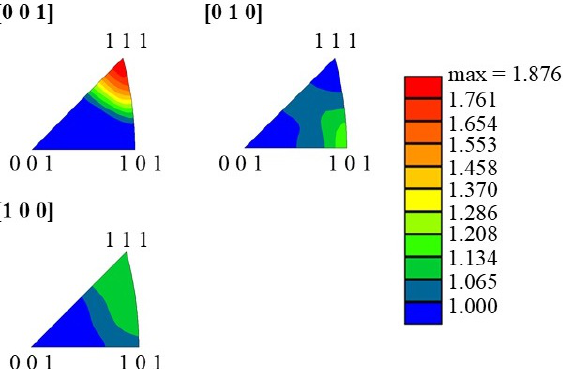
Figure 14. Inverse pole figures of WAAM-fabricated S355JR steel in relevant testing directions with an intensity maximum of H max = 1.876